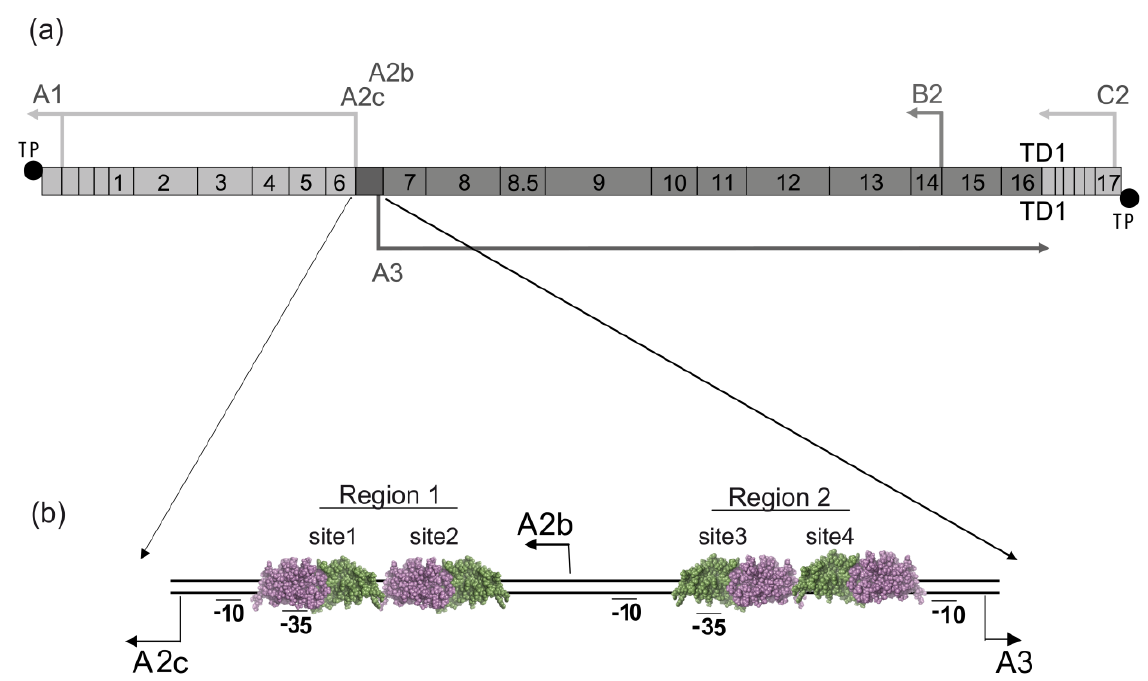
Figure 1. ( a ) Genetic and transcription map of phage Ø29. Genes are indicated by numbers from 1 to 17. Location of the promoters A1, A2c, A2b, A3, B2 and C2 are indicated, and the transcription terminator TD1 is denoted; ( b ) detail of the Ø29 genome intergenic region between early promoter A2c and late promoter A3. Protein p4 dimer is represented in violet-green. Protein p4 binding region 1 contains sites 1 and 2 and region 2 contains sites 3 and